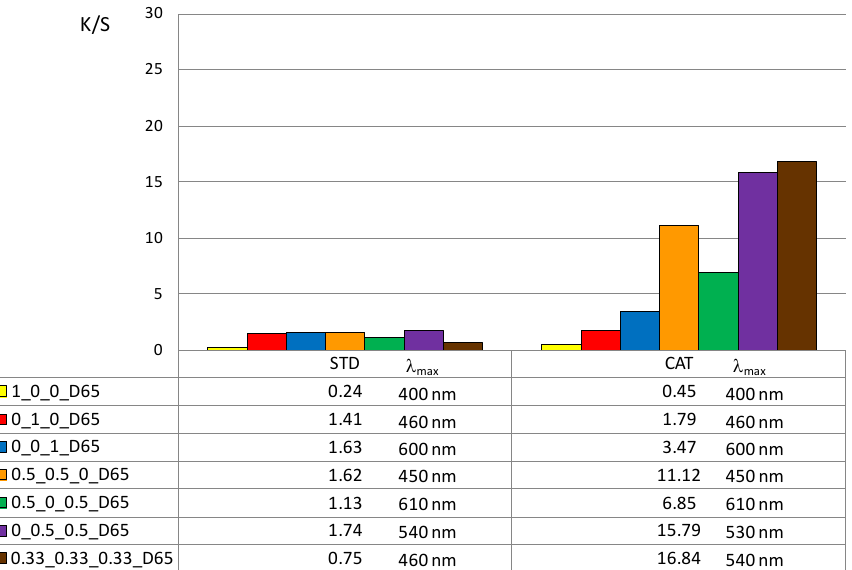
Figure 5. Maximum K/S values of standard and cationized fabric dyed with 1% owf dye.